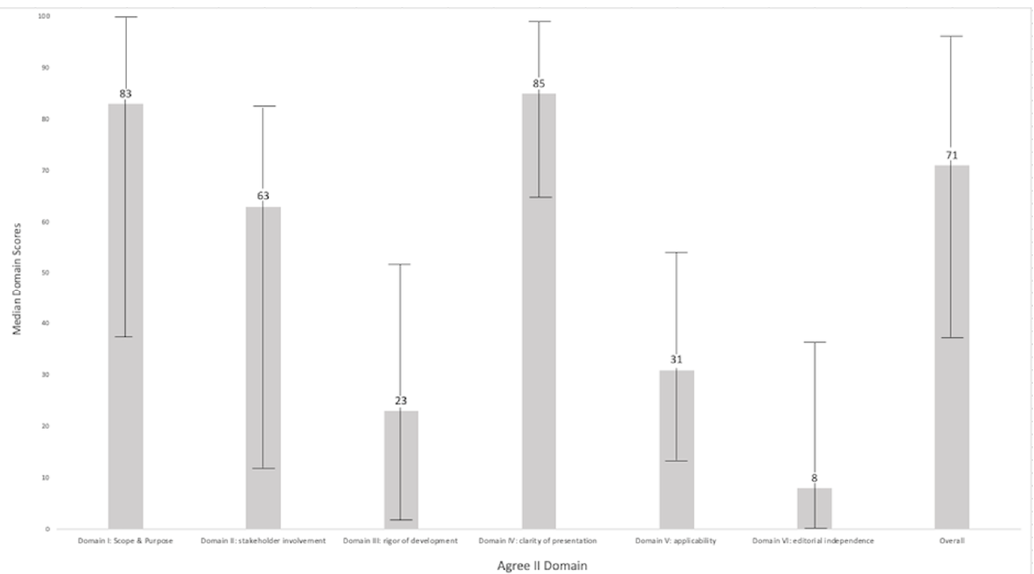
Figure 3. Median domain scores and range for all appraised ASGs. Table 3. Intraclass correlation coefficients, 95% confidence intervals and interpretation for each AGREE II item.